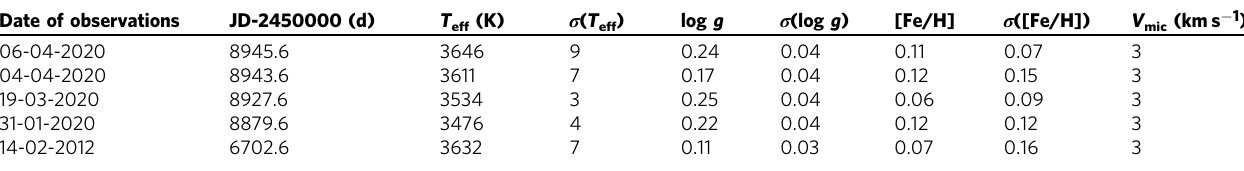
Table 1 Physical parameters of Betelgeuse obtained in this study.